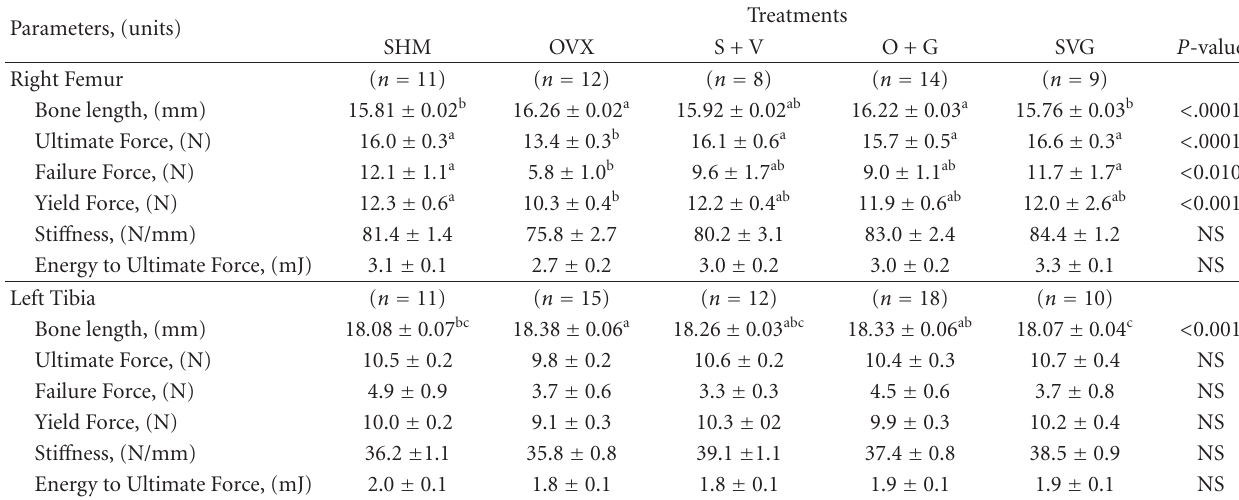
Table 3: Bone length and mechanical strength of the femur and tibia of mice during ex vivo three-point testing. Treatments Parameters, (units) SHM OVX S + V O + G SVG P -value Right